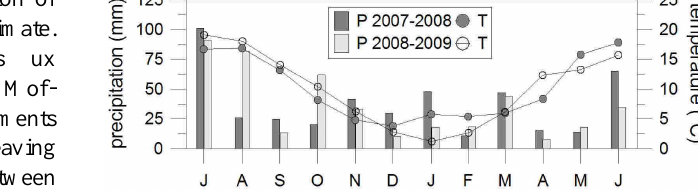
Fig. 2. Monthly values of precipitation and air temperature of both years in comparison. Both years do not differ significantly (permu- tation test) with regard to bulk annual values of these two variables, although considerable differences between some months did